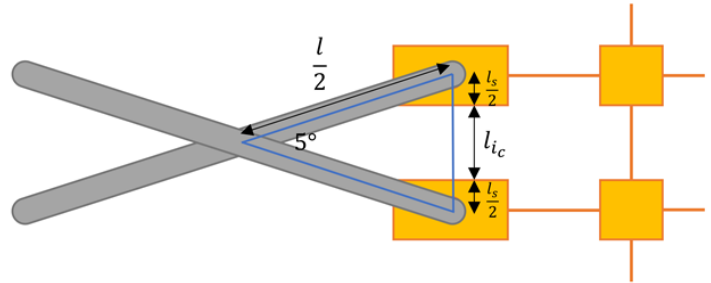
Figure 11. Geometry of the closed scissor-hinge unit.